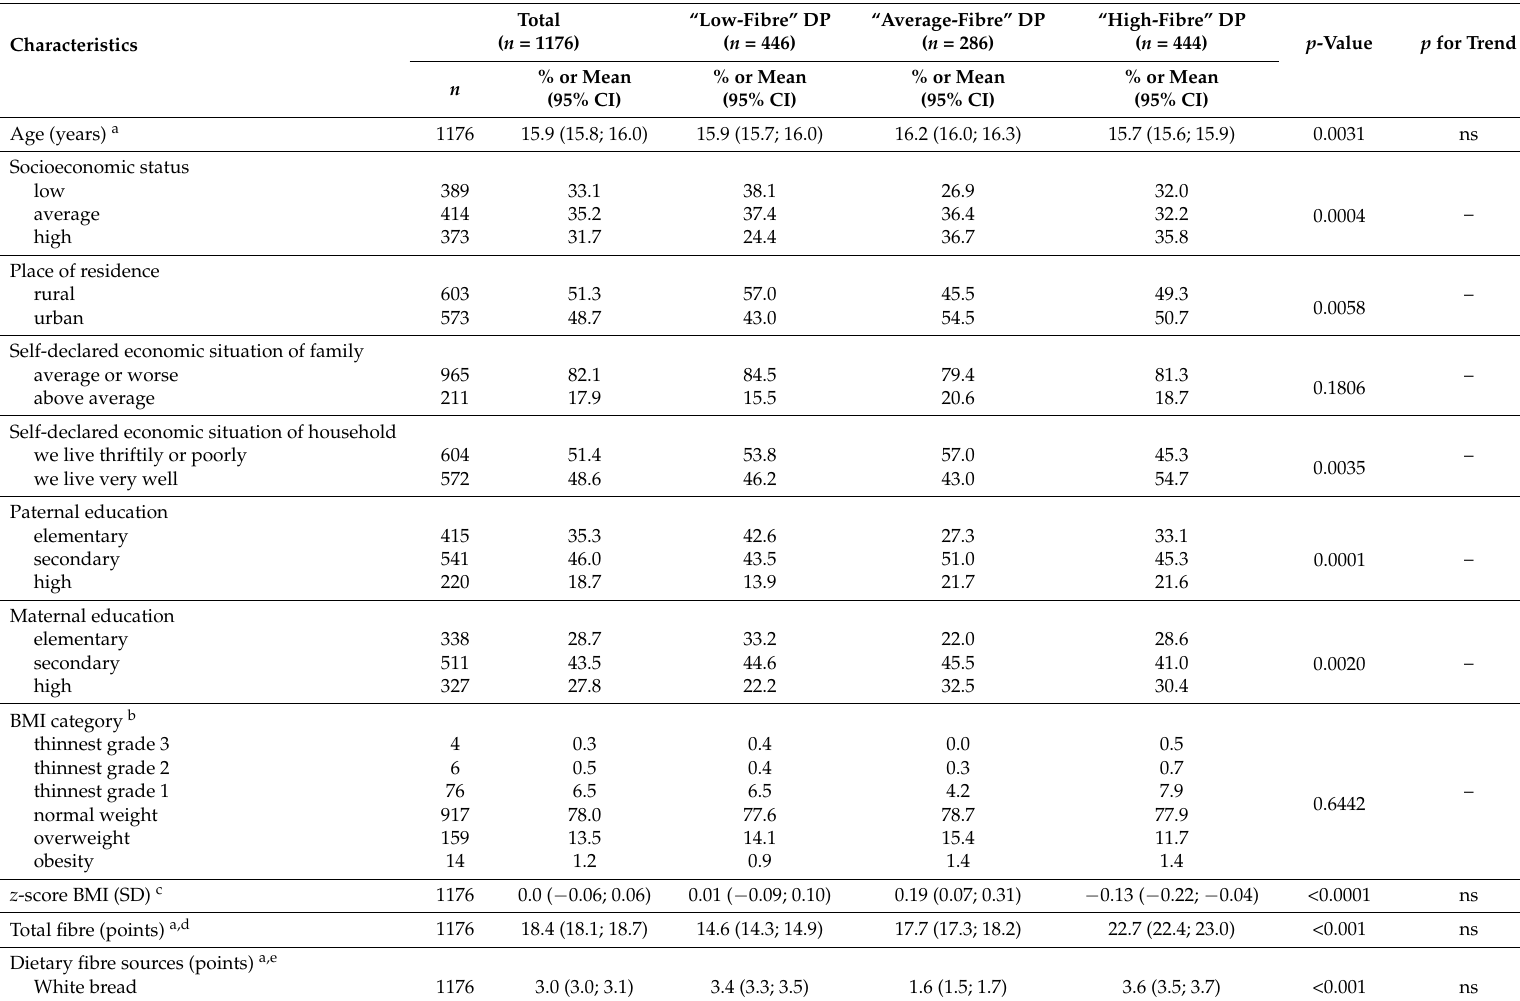
Table 1. Socioeconomic status (SES) single factors and frequency of fibre intake by fibre dietary patterns (DPs) in Polish adolescents.